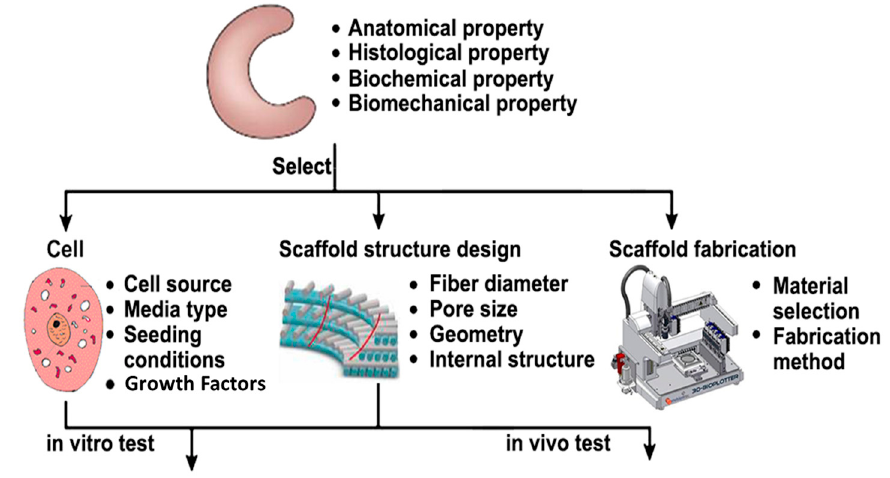
Figure 2. Scaffold-based approach for meniscus regeneration.